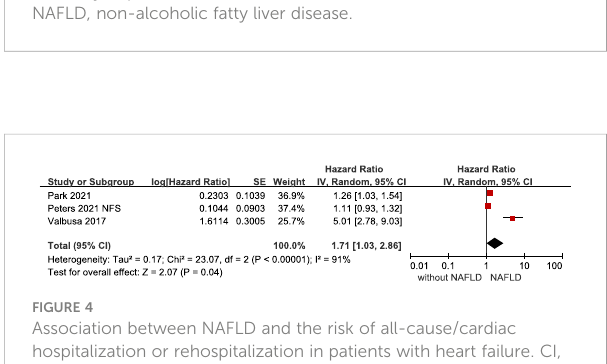
FIGURE 3 Association between NAFLD and the risk of all-cause/cardiac mortality in patients with heart failure. CI, con fi dence interval; NAFLD, non-alcoholic fatty liver disease.